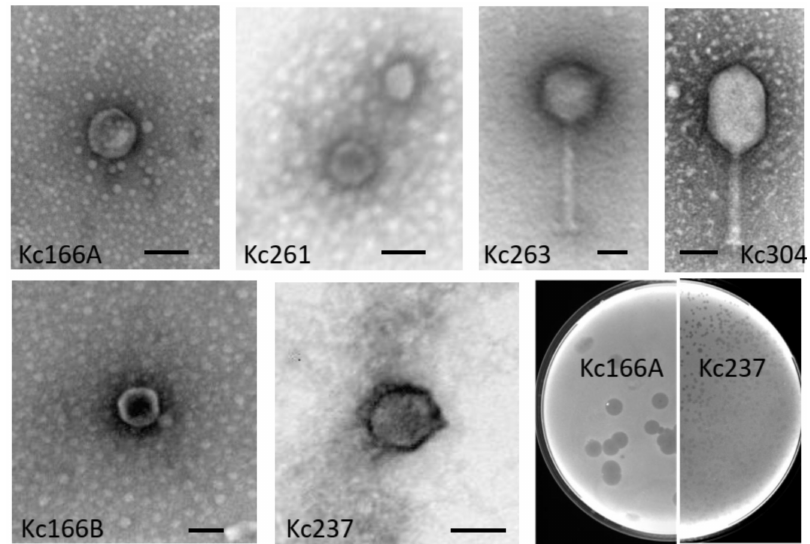
Figure 1. Morphology of the viruses. Purified viruses were stained with uranyl acetate and observed by JEOL 1010 electron microscope. Bars represent 50 nm. Plaque size of Kc166A and Kc237 viruses on 0.45% agar after 16 h